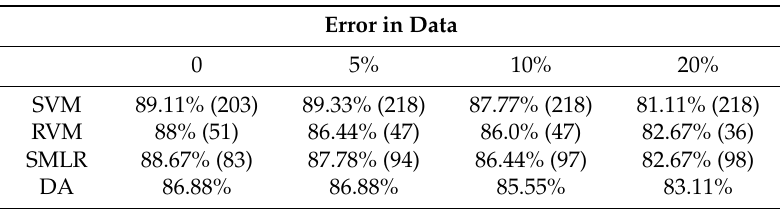
Table 4. Overall classification accuracy for cases mislabelled to a similar class. Values in brackets are the number of support vectors, relevance vectors, and useful kernel basis functions used.